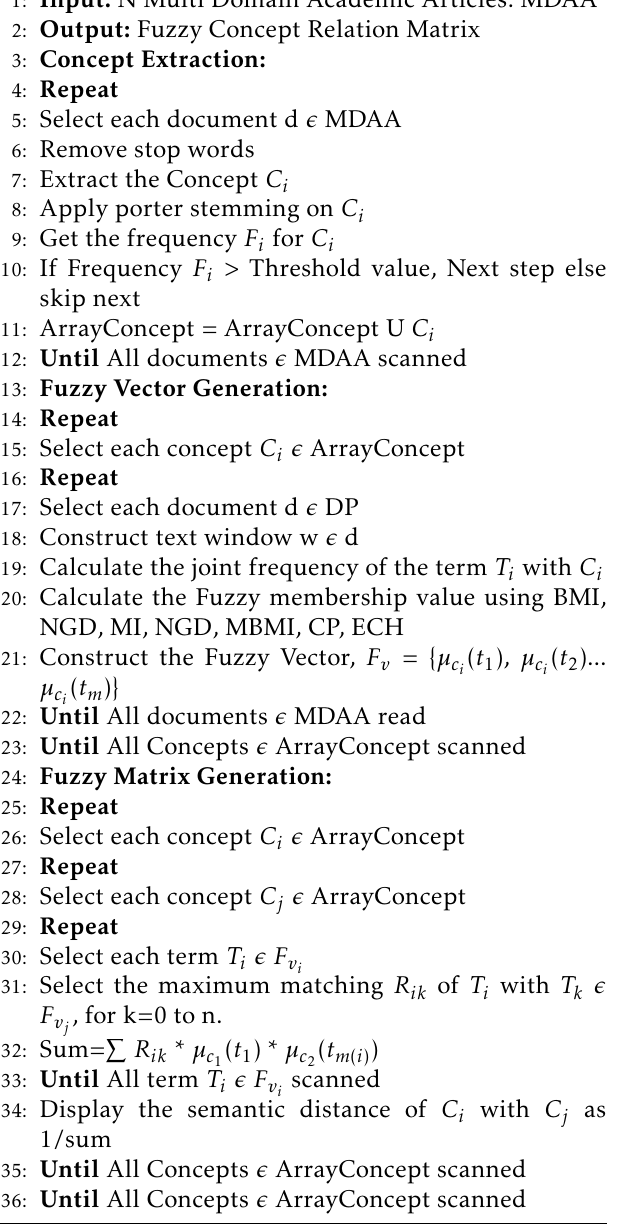
Algorithm 1 Semantic Relatedness